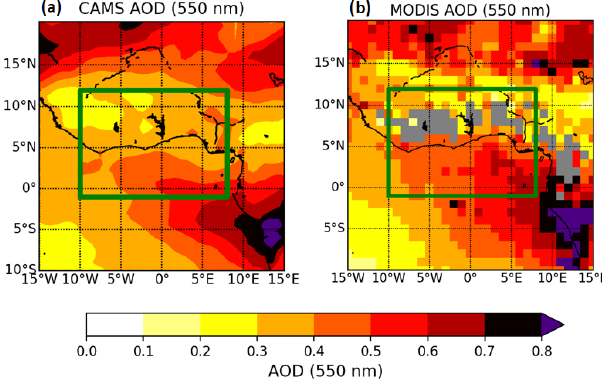
Figure A1. Aerosol Optical Depth (AOD) averaged for the period 1–7 July 2016 for (a) Copernicus Atmosphere Monitoring Service (CAMS) at 09:00 and 13:00UTC, and for (b) the Moderate Res- olution Imaging Spectroradiometer (MODIS) retrieved by the in- struments on the Terra and the Aqua satellites (datasets: MOD08- D3 and MID08-D3). Missing values in (b) are colored in gray. The green rectangle represents the studied domain.